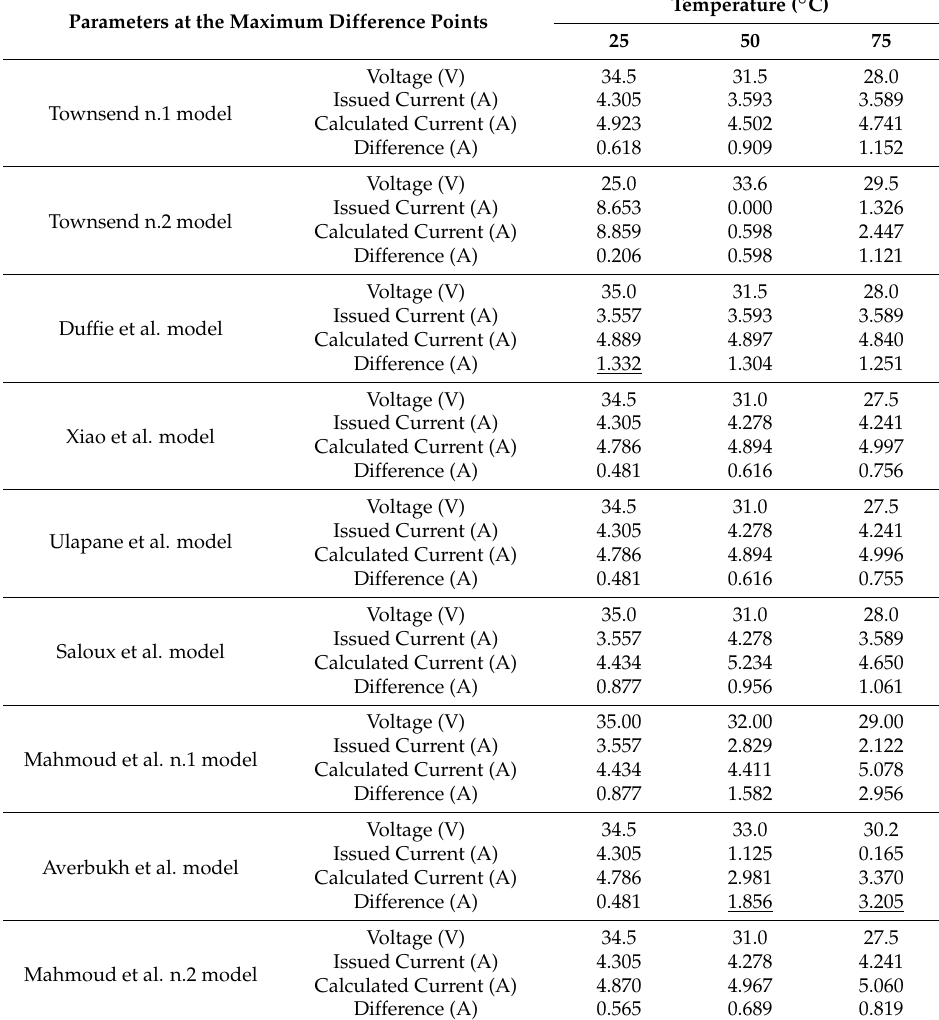
Table 9. Maximum current differences between the calculated and the issued I-V characteristics of